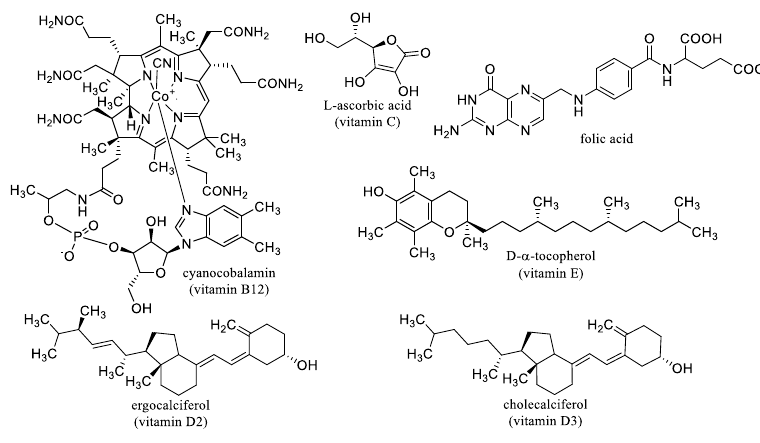
Figure 2. Structures of vitamins supporting immunity.